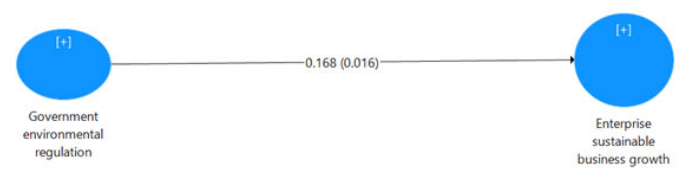
Fig. 4. Direct impact of Government environmental regulation on Enterprise sustainable business